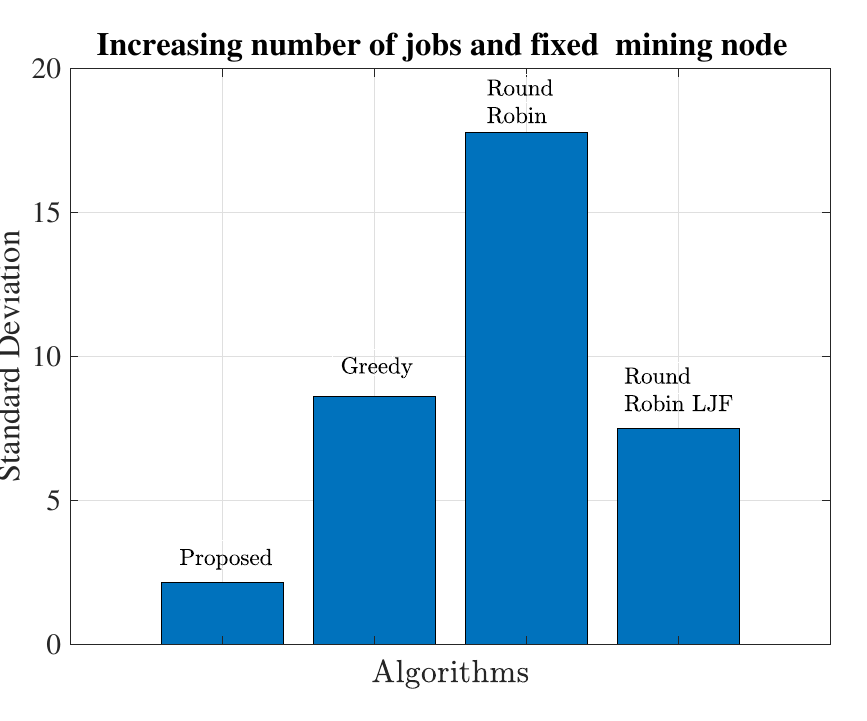
Figure 6. Standard deviation against a varying number of mining